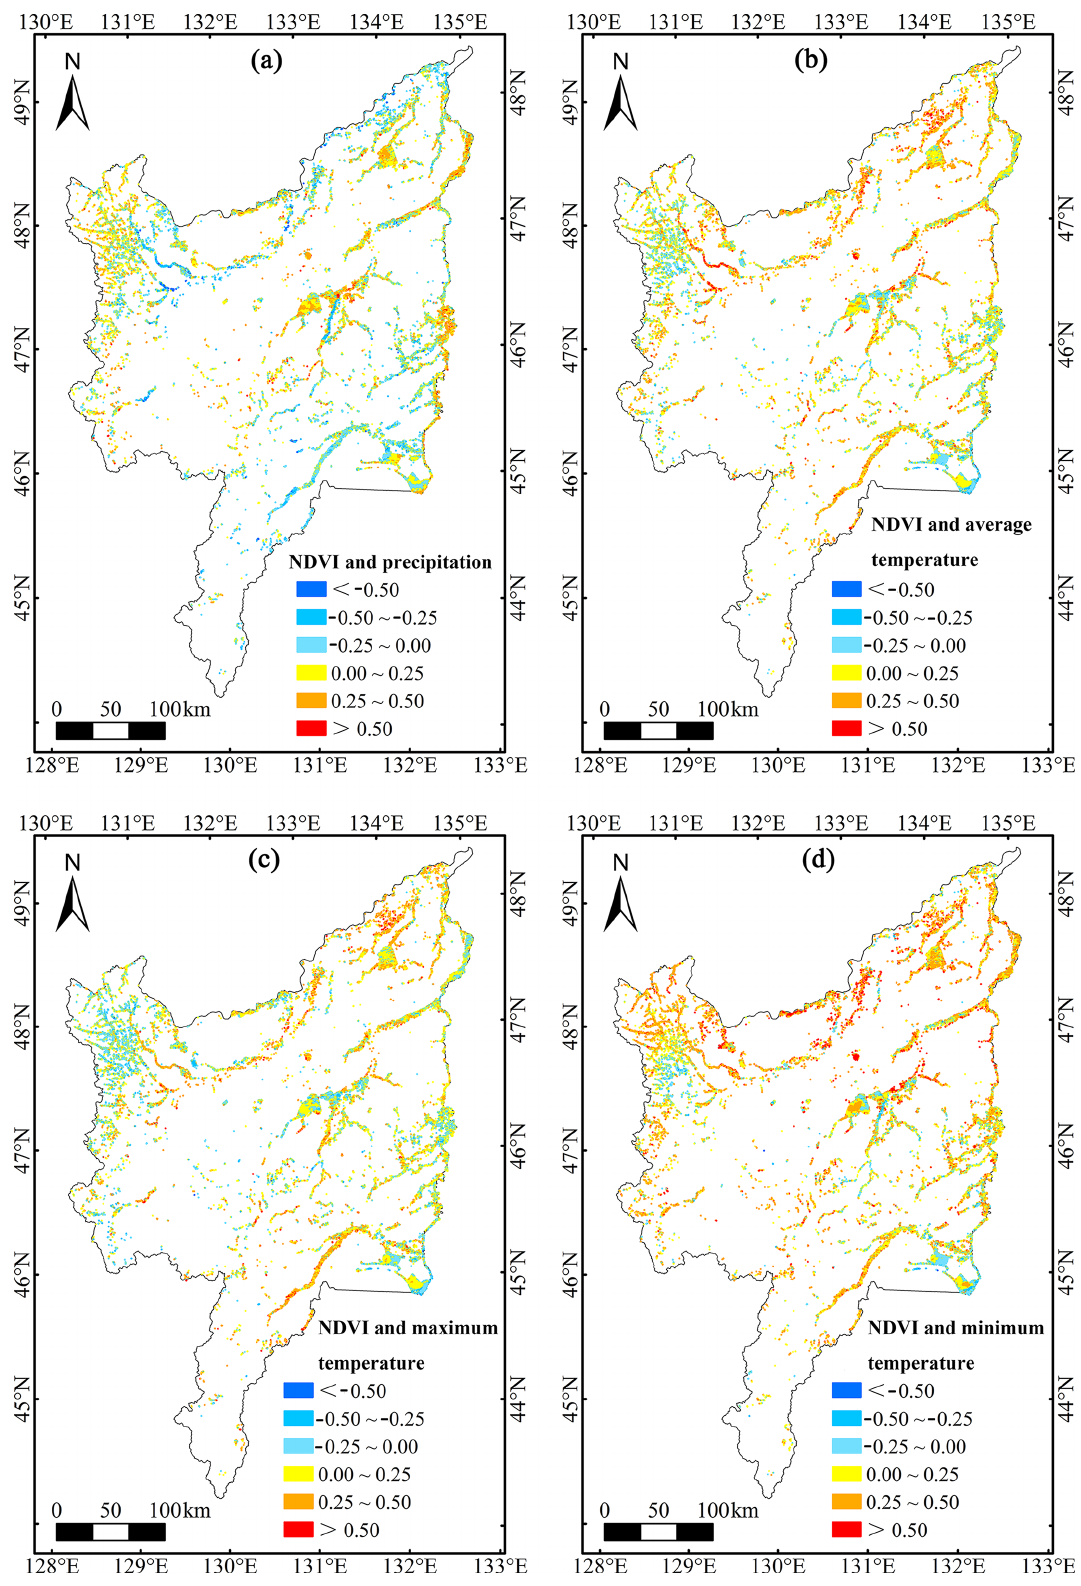
Figure 5. Spatial distribution of relationships between July NDVI of marsh vegetation and July ( a ) precipitation, ( b ) average temperature, ( c ) maximum temperature and ( d ) minimum temperature in the study region from 2000 to 2020.